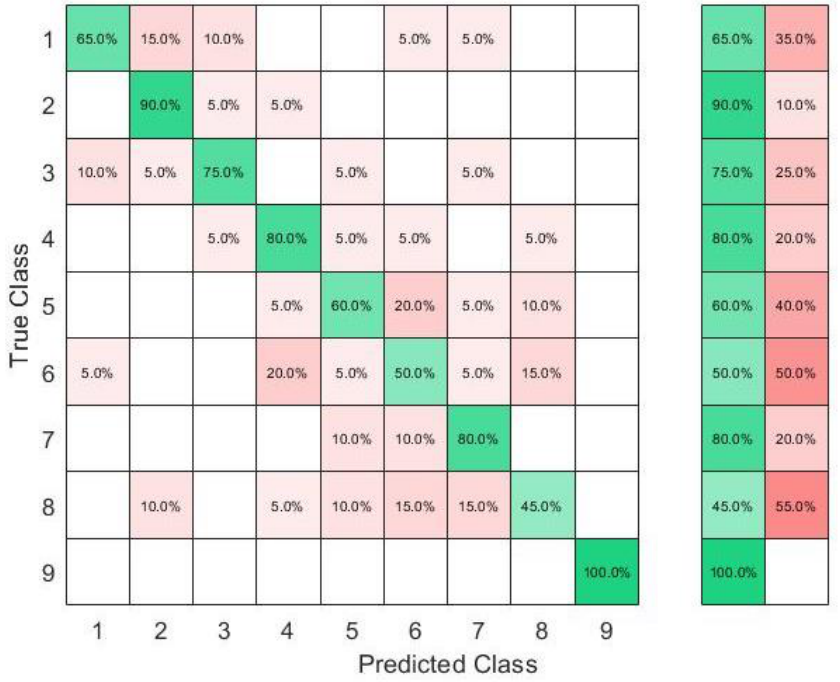
Figure 6. Confusion matrix of the KTGEL for ten person and nine numbers: 6